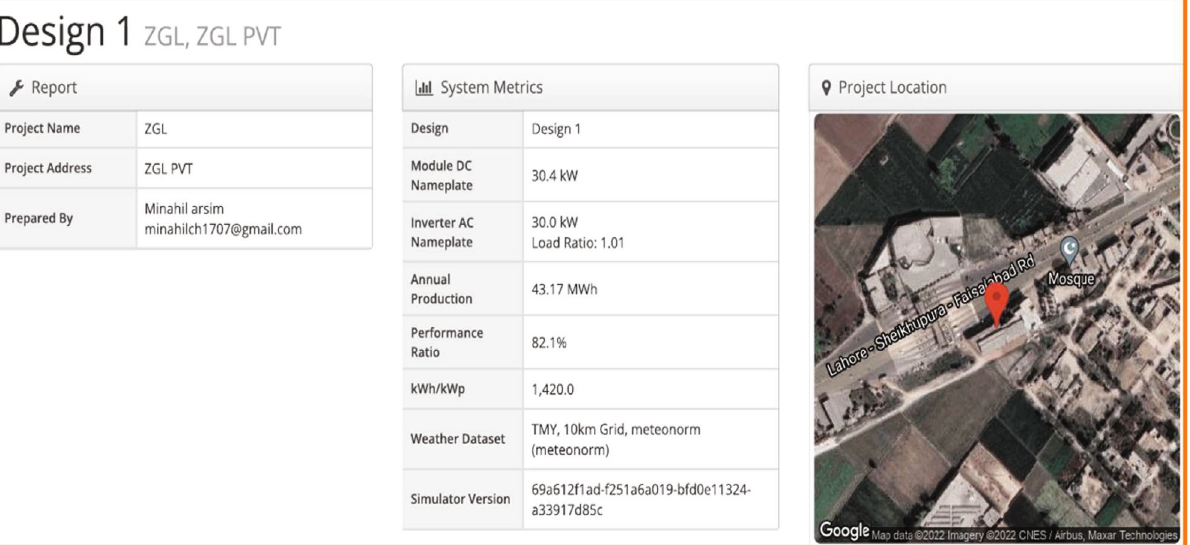
Figure 1: Simulation of installed PV system (15 kWp).